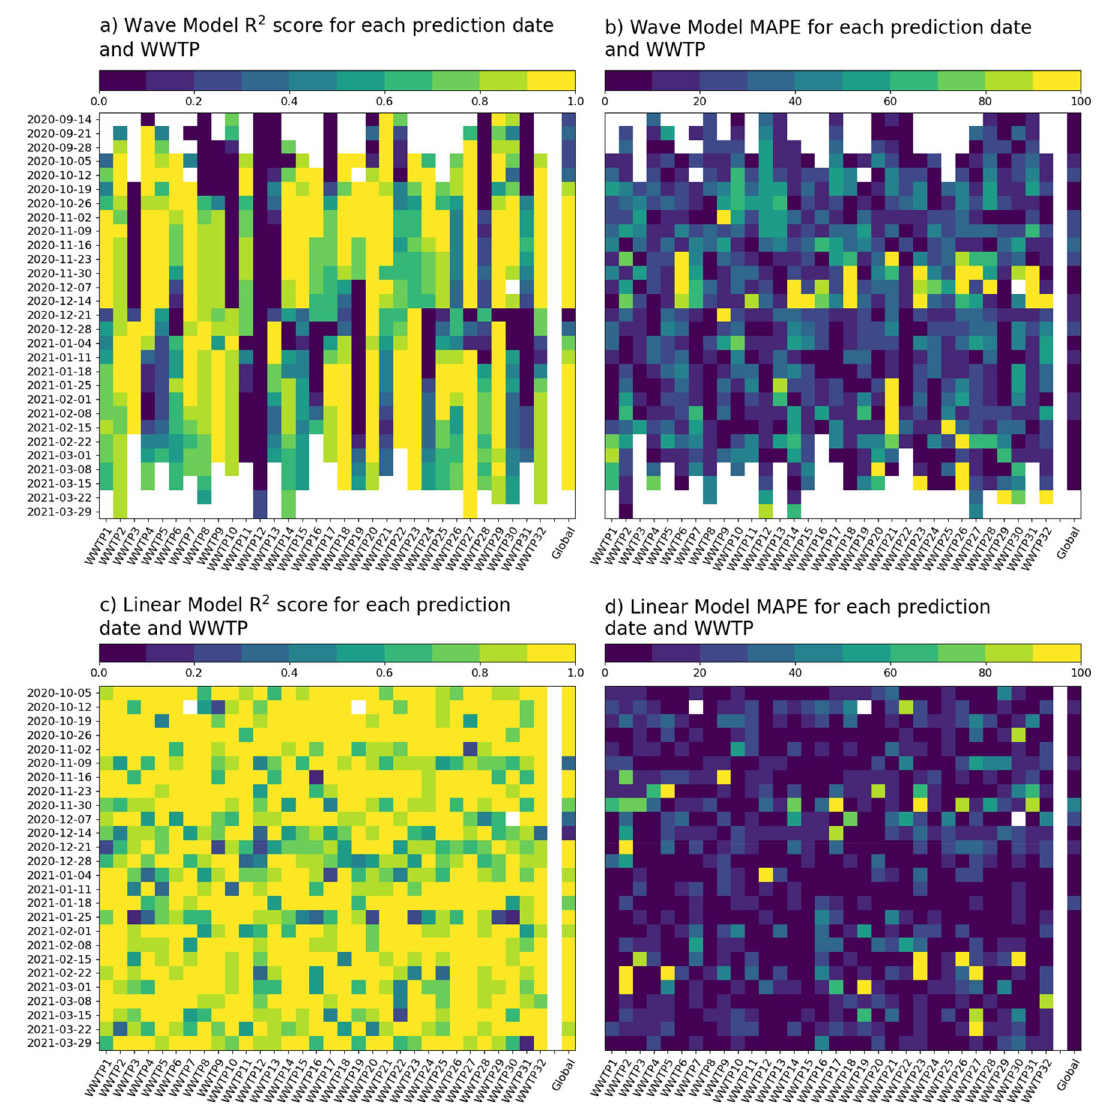
2 Figure 7. R scores ( a and c ) and MAPE ( b and d ) of the Wave Model with increasing fitting window forecasts ( a and b ) and the Linear Regression with sliding 2-week fitting window ( c and d ) for each WWTP and prediction date. Note that good performance is related to a yellow colour in the R and a blue colour in the MAPE heatmap (low